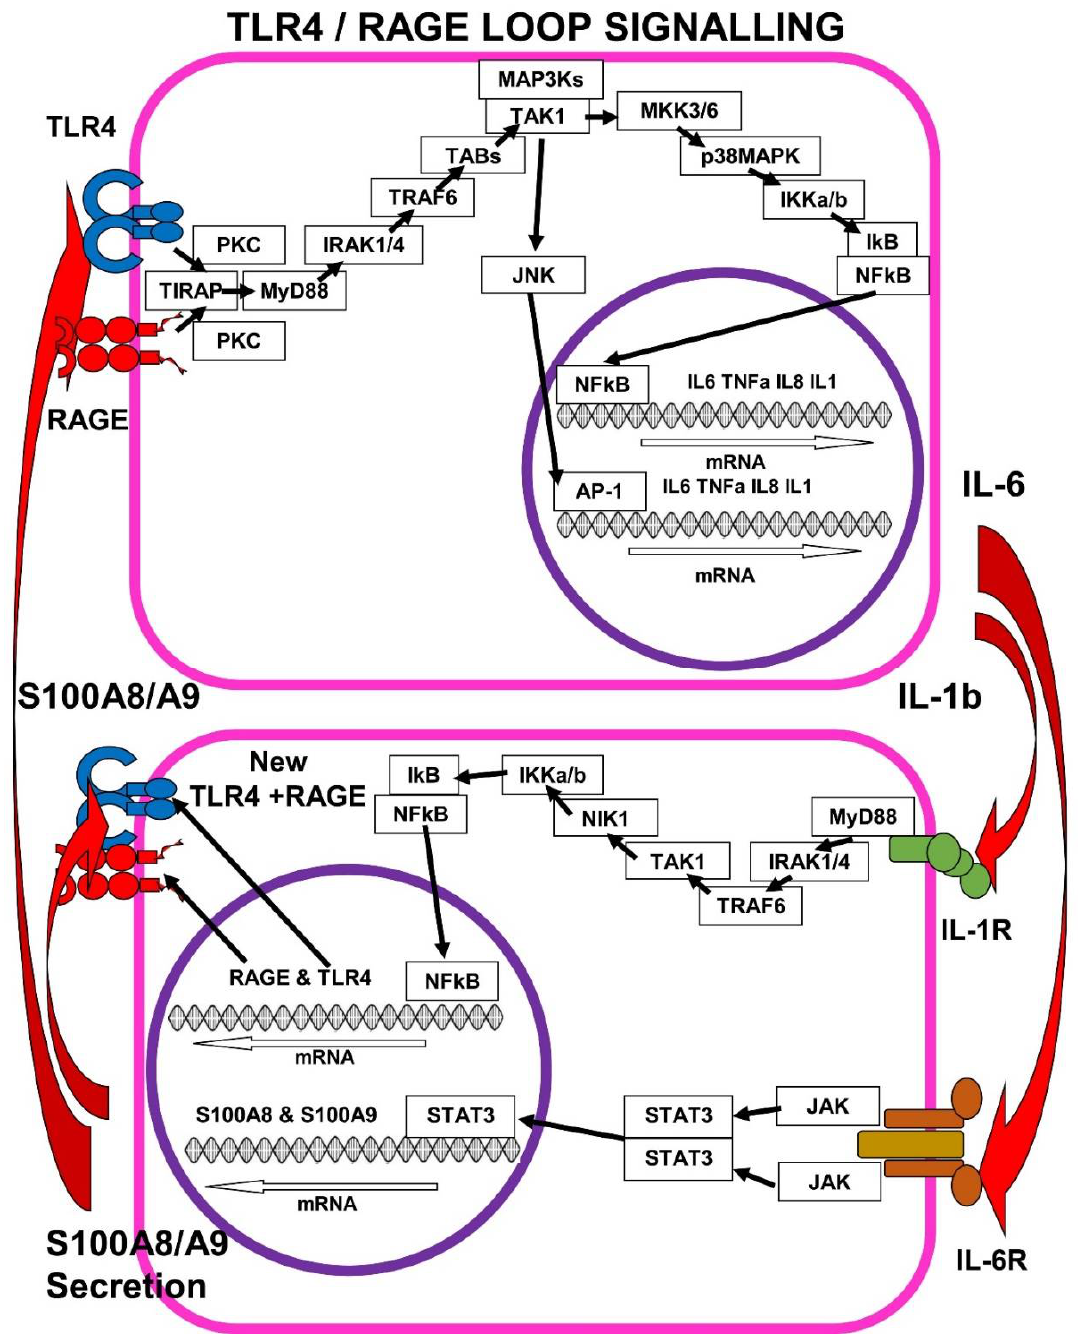
Figure 2. High serum concentrations of S100A8/A9 trigger TLR4 and RAGE to activate the TIRAP+Md88 to NFkB and AP-1 signalling cascade, which results in hyper-expression of pro-inflammatory IL-1b and IL-6, which is secreted by the activated cells. High levels of serum IL-1b trigger IL-1R and the MyD88 to NFkB signalling pathway that upregulates the expression of new TLR4 and RAGE. High levels of serum IL-6 trigger IL-6R and the JAK/STAT signalling pathway which induces the expression of more pro-inflammatory S100A8 and S100A9 genes. After translation of the mRNA to polypeptides, S100A8/A9 hetero-dimer is secreted and the high concentrations in the serum trigger more TLR4 and RAGE, completing a pro-inflammation circuit, which does not require viral protein to persist.